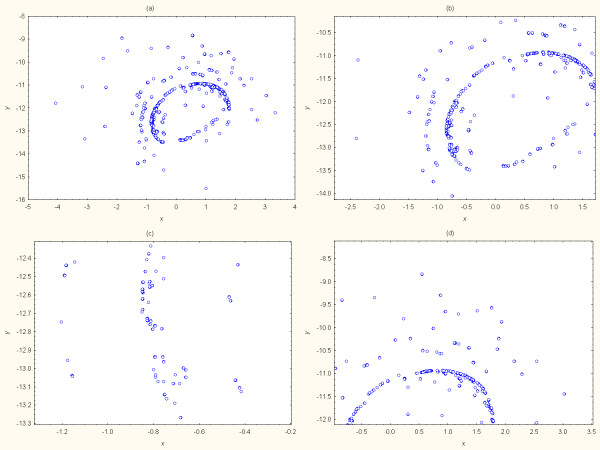
Relaxation map for the chromatin interactome network. Each panel depicts different regions and levels of detail, obtained with 100 iterations.